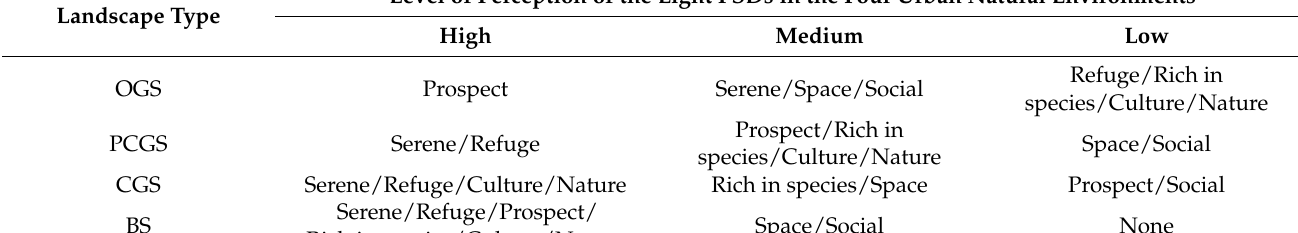
Table 4. The three-scale levels of perception of the eight PSDs.